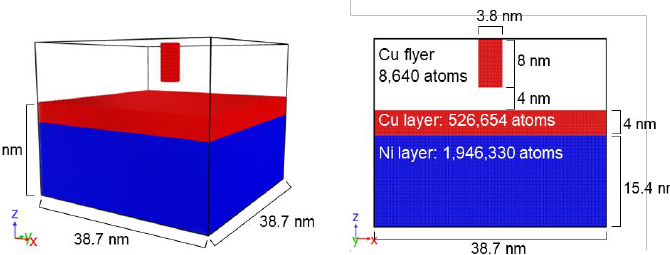
Figure 1. The perspective and front views of the Cu/Ni bilayer and cylindrical Cu flyer plate where Cu atoms are shown in red and Ni in blue.